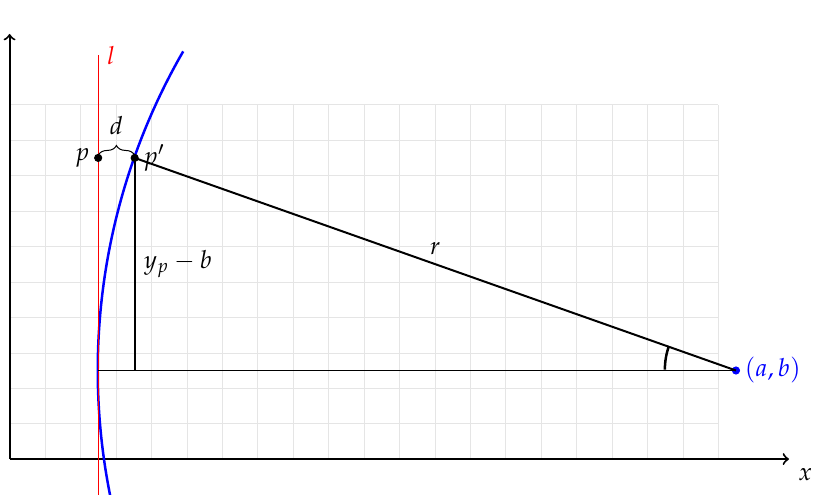
Figure 4. Emission line l is shown in red, and the fitted circular arc corresponding to it is shown in blue. The light gray grid represents the sensor of the camera. In reality, the radius of the circle would be several times larger than the width of the cropped frame acquired from the